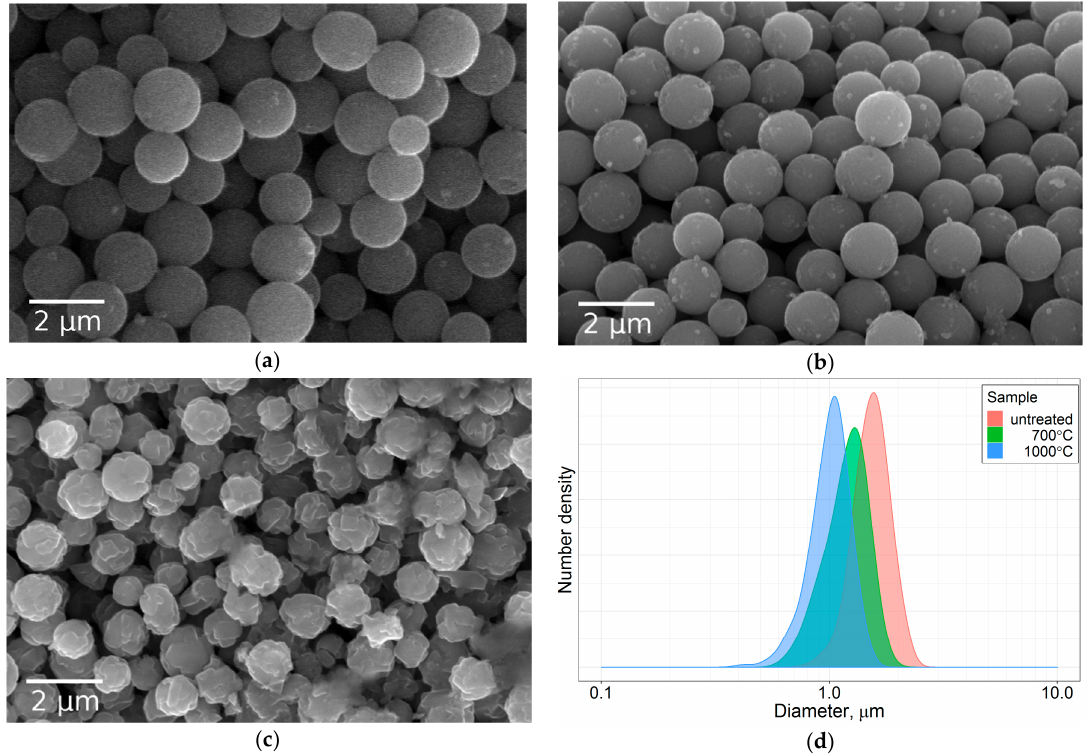
Figure 7. SEM shows that after annealing, the particles preserve their spherical morphology, but shrink in size: ( a ) untreated, ( b ) annealed at 700 °C, ( c ) 1000 °C, ( d ) respective particle size distributions according to analysis of SEM